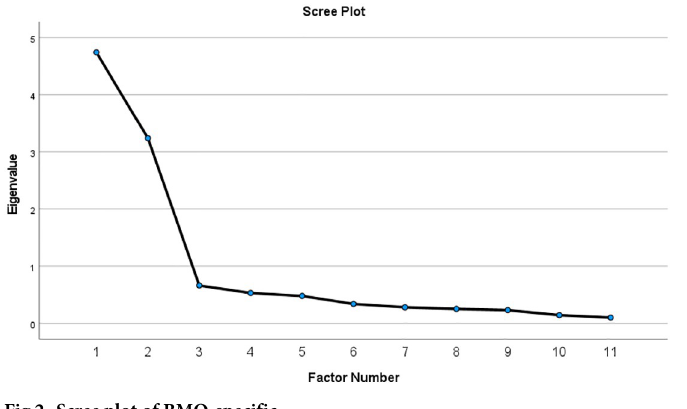
Fig 2. Scree plot of